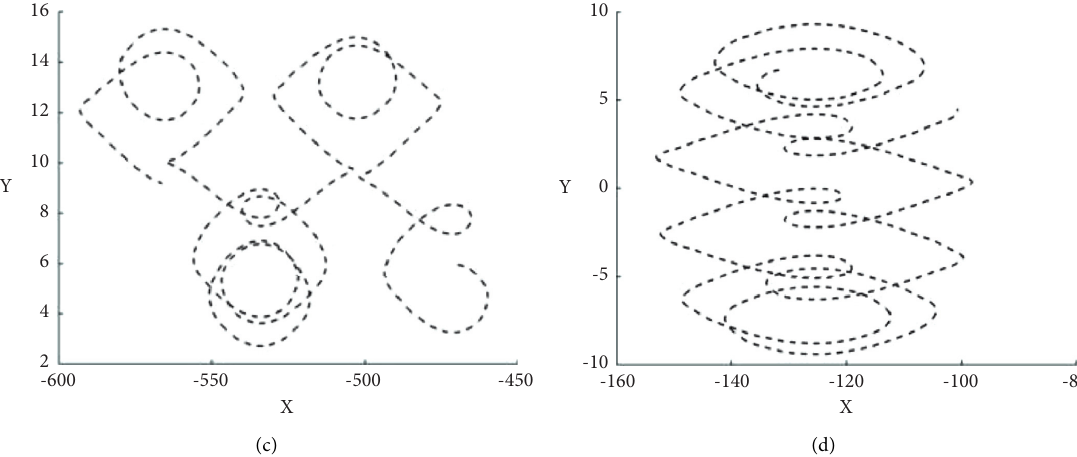
Figure 12: Phase portrait in the plane ( x,y ) for System (2) illustrating megastability obtained by considering random initial conditions distributed around the x -axis. The frequency of the forcing term is ω � 0 . 6, and the amplitude A � 9 . 7. Adding a forcing term can make the system exhibit various